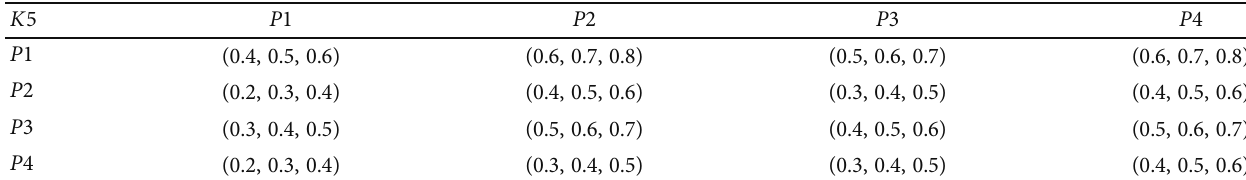
Table 10: Matrix of indicators of environmental impact